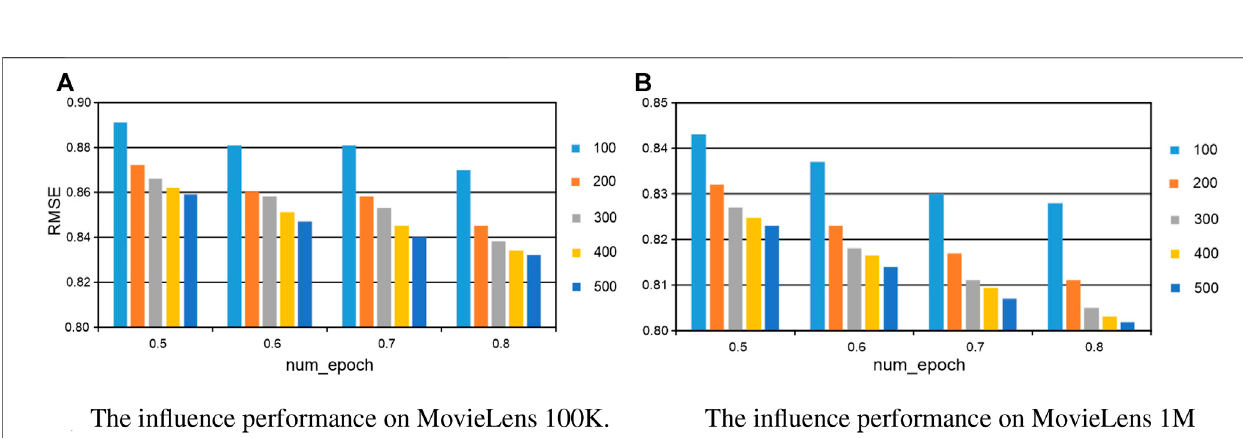
FIGURE6| Theparameter in fl uenceofthenumberofepochson ourKGTA. (A) Thein fl uenceperformanceonMovieLens 100K. (B) Thein fl uenceperformanceon MovieLens 1M.